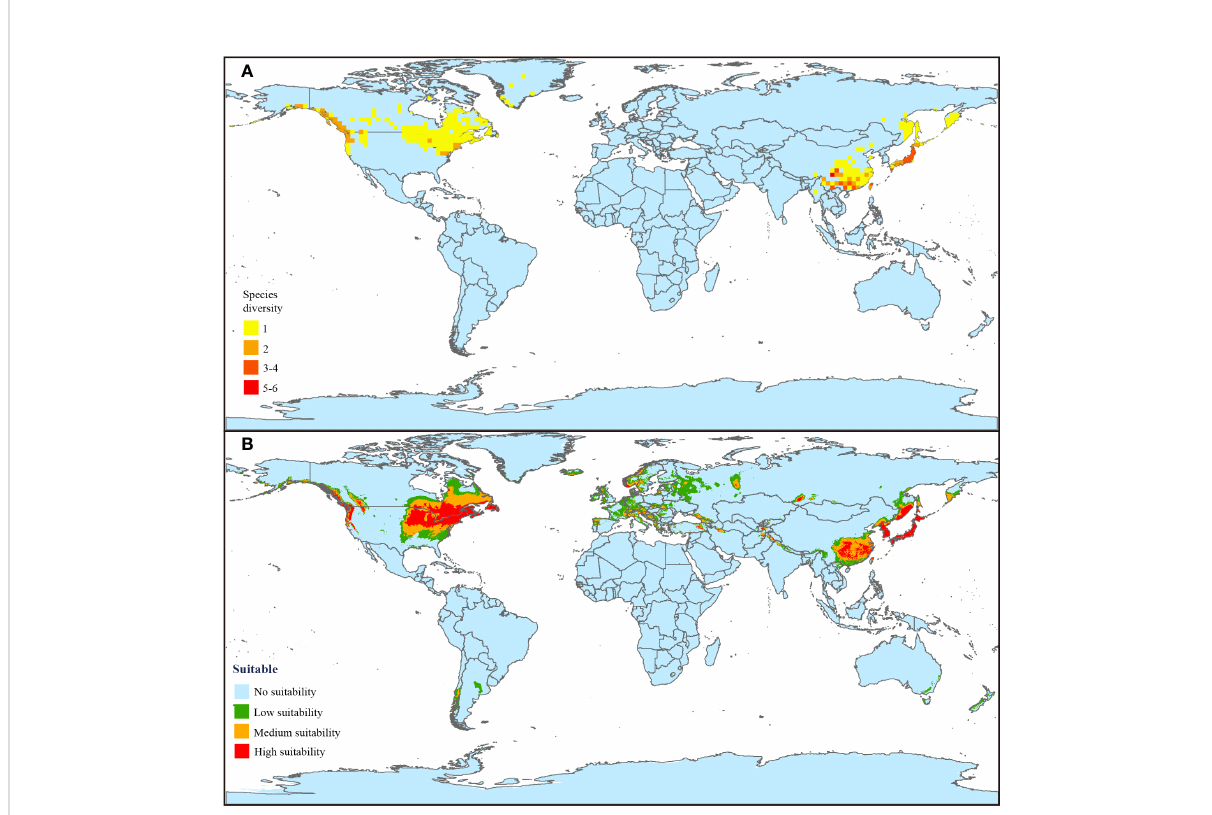
FIGURE 2 Current distribution and suitable habitat prediction of Coptis . (A) Current species distribution and diversity pattern. The global land area was divided into 2° grid cell by ArcGIS and the number of species per grid were counted to determine the species diversity of Coptis . The redder the grid, the higher the species diversity. (B) Current potential distribution of Coptis under 1970 – 2000 climate conditions. Four levels of suitability are shown in different colors as follows: no suitability (0-0.2, blue); low suitability (0.2-0.4, green); medium suitability (0.4-0.6, yellow); and high suitability (0.6-1,